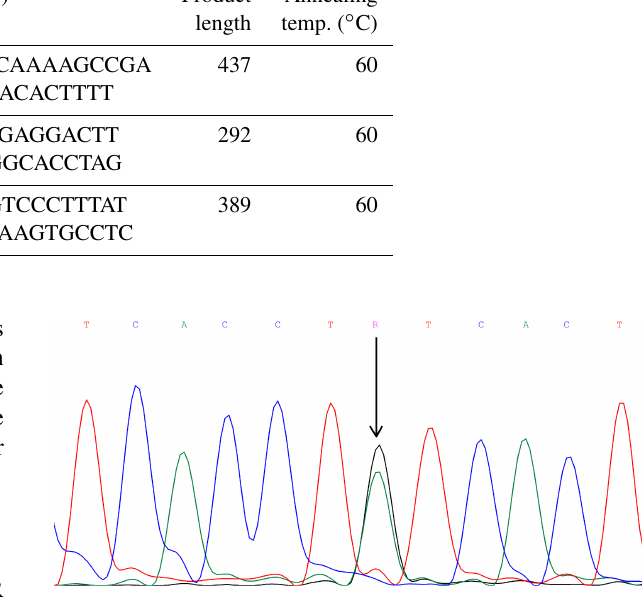
Table 1. Primer sequences used for the amplifications of the bovine FADS2 exons (1, 3, and 12). Region Primer sequences (5 (cid:48) –3 (cid:48) ) Product